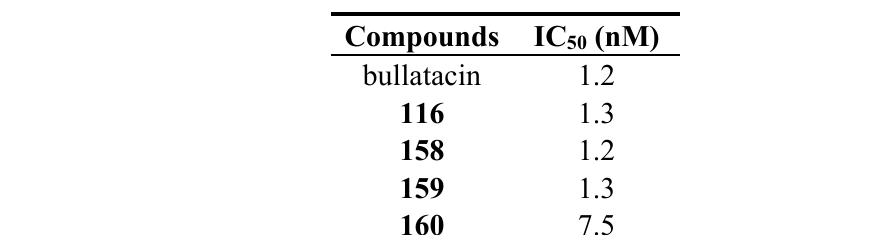
Table 11. Inhibition of mitochondrial complex